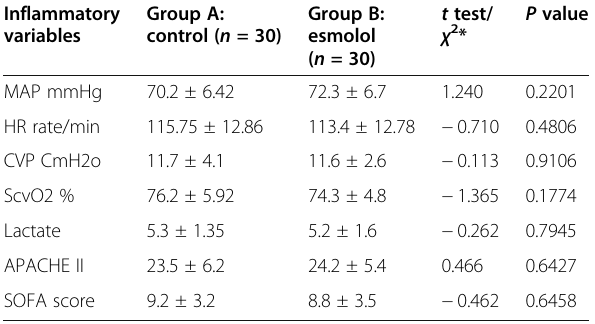
Table 2 Comparison between both groups according to admission data